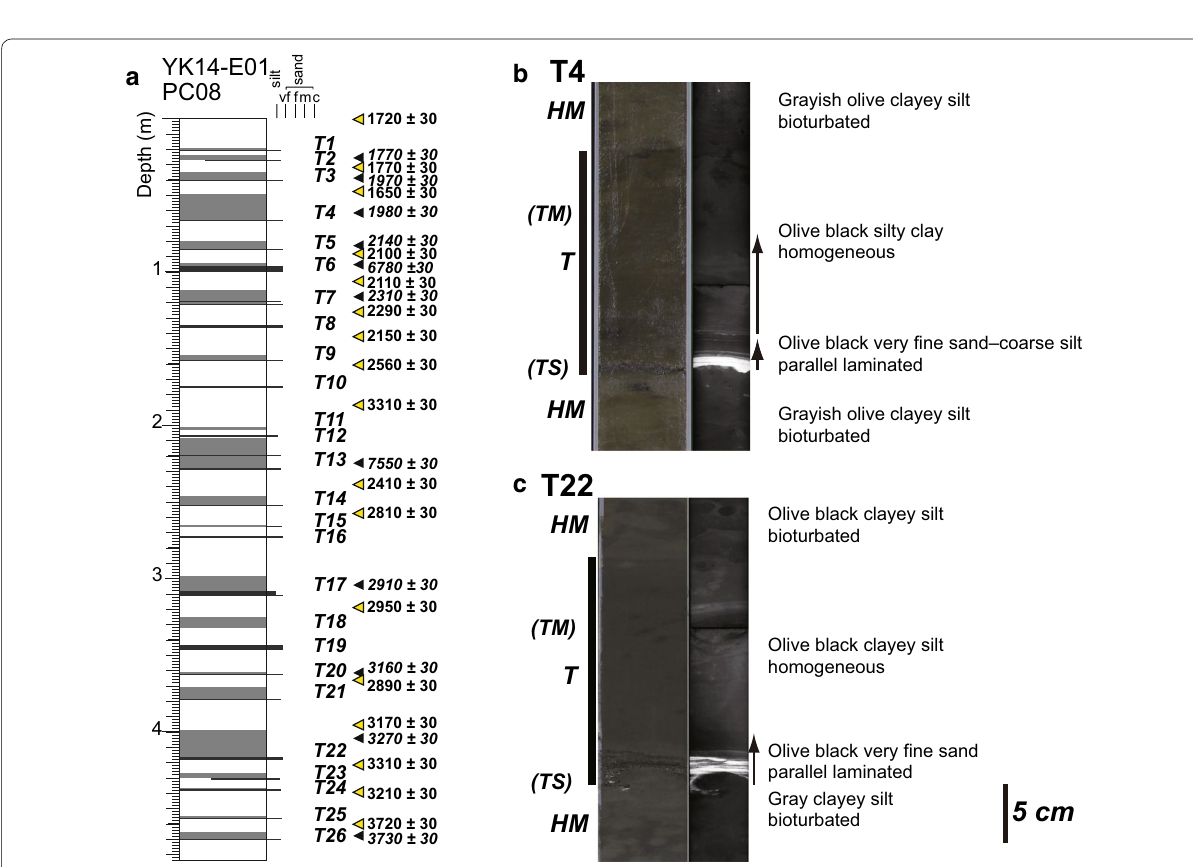
Fig. 2 a Columnar section and results of radiocarbon age determinations, b core photograph (left), soft-X radiograph (right) and brief sediment description of T4, c core photograph (left), soft-X radiograph (right) and brief sediment description of